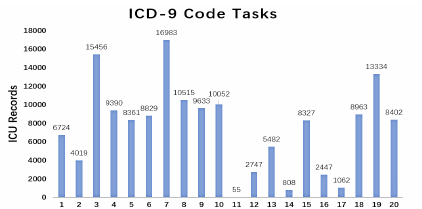
Figure 8. The label distribution in ICD-9 Code tasks. x -axis, label id in the ICD-9 diagnosis category; y -axis, the number of ICU records with positive